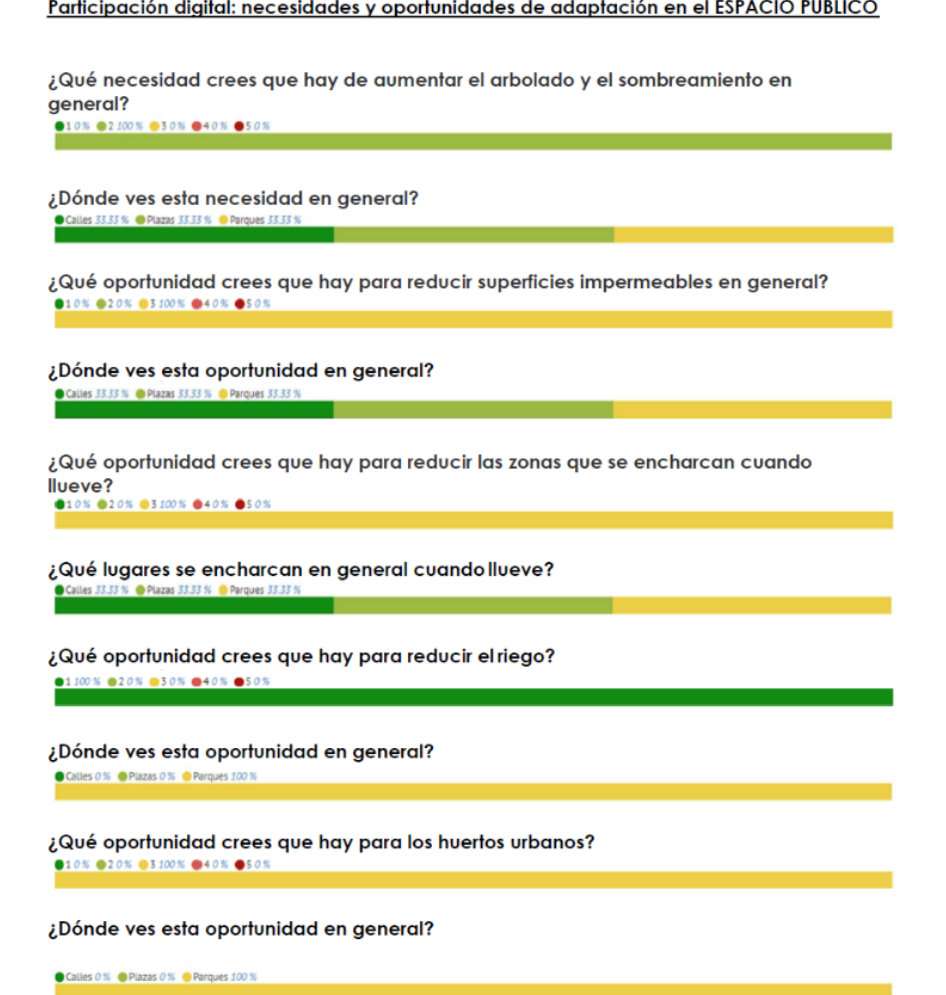
Figure 8. Consensus bars of the consultation method of Balmaseda.